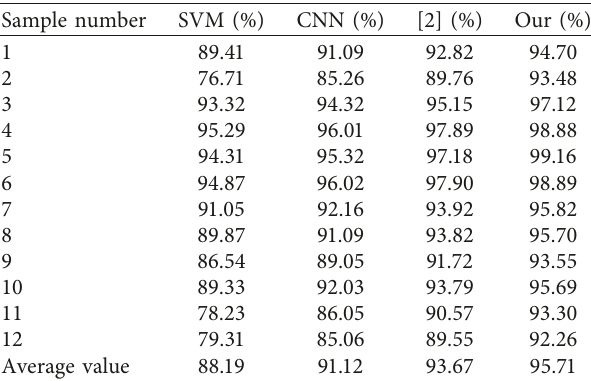
Table 4: Brain tumor tissue classification results. Sample number